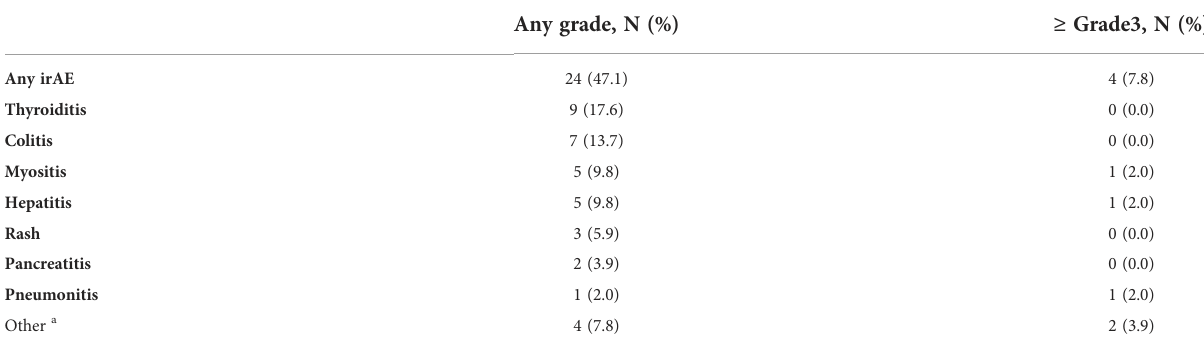
TABLE 2 Immune-related adverse